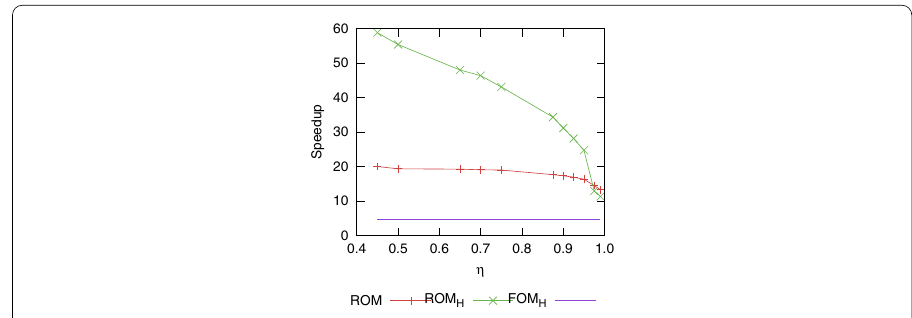
Fig. 10 Speedup for ROM and hyper-ROM